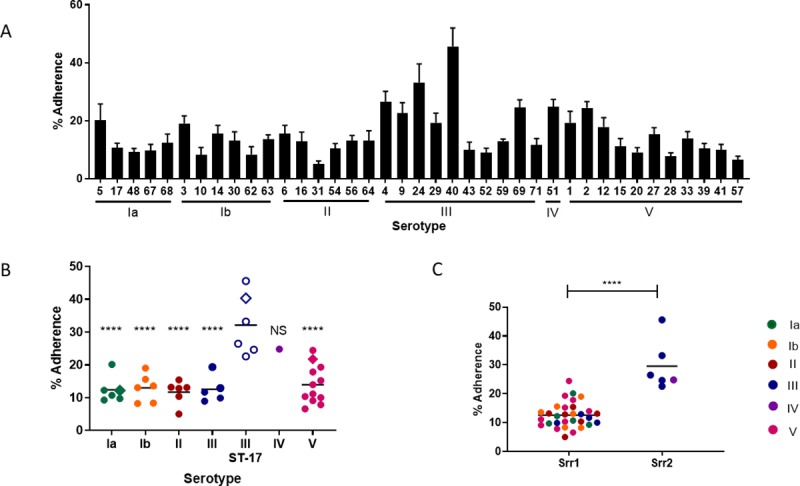
Vaginal epithelial cell adherence.A) Adherence of GBS clinical isolates to human vaginal epithelial cells (VK2/E6E7) at MOI = 1. Data represent the average of three independent experiments, each performed with three technical replicates. B) Adherence separated by serotype along the x-axis and compared to invasive isolates COH1, A909, and CJB111, denoted by diamonds. Open symbols represent isolates belonging to the hyper-virulent sequence type 17 (ST-17) lineage. Data were analyzed by a one-way ANOVA with Sidak’s multiple comparisons test, with each serotype compared to all others. Non-ST-17 samples (Ia, Ib, II, III, IV, and V) were compared to serotype III, ST-17 strains, **** p < 0.0001. No significant differences were detected between non-ST-17 samples. C) Adherence percentages separated by the presence of serine-rich repeat glycoproteins (Srr1 or Srr2). Symbol colors in panels B & C indicate capsular serotype. Data were analyzed by a one-way ANOVA with Sidak’s multiple comparisons test, **** p < 0.0001.